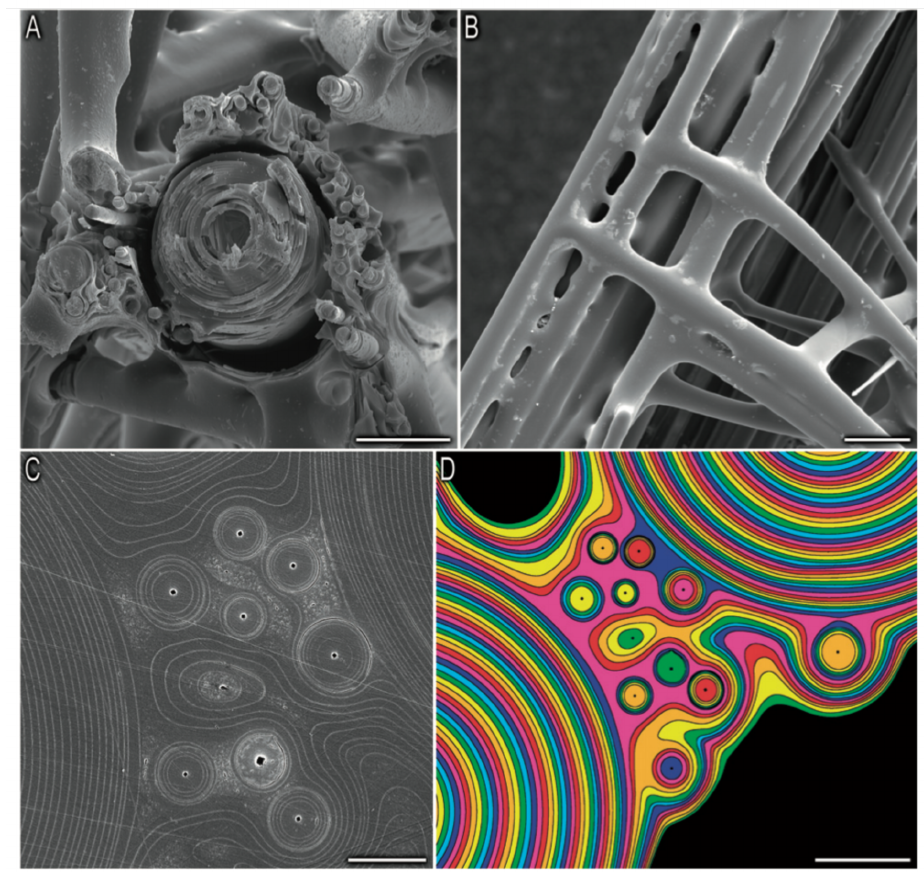
Figure B1. Picture from Weaver et al. (2007). Organisational details of the consolidation silica matrix. (a) Cross section of the skeletal lattice showing a large spicule surrounded by small spicules, scale bar: 50µm. (b) External view of the skeletal lattice, scale bar: 100µm. Panels (c) and (d) show a polished cross section showing that the cement of the skeletal lattice is made of multiple layers, scale bar: 10 and 20µm